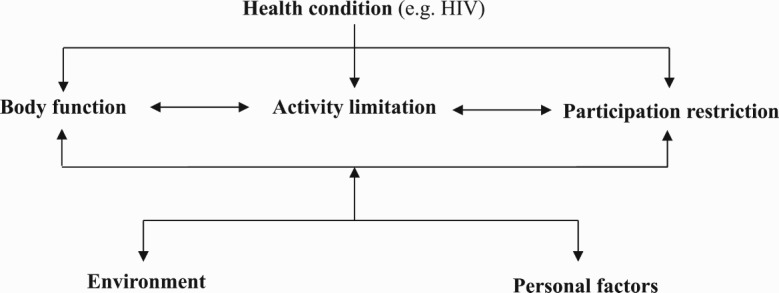
ICF conceptual framework.